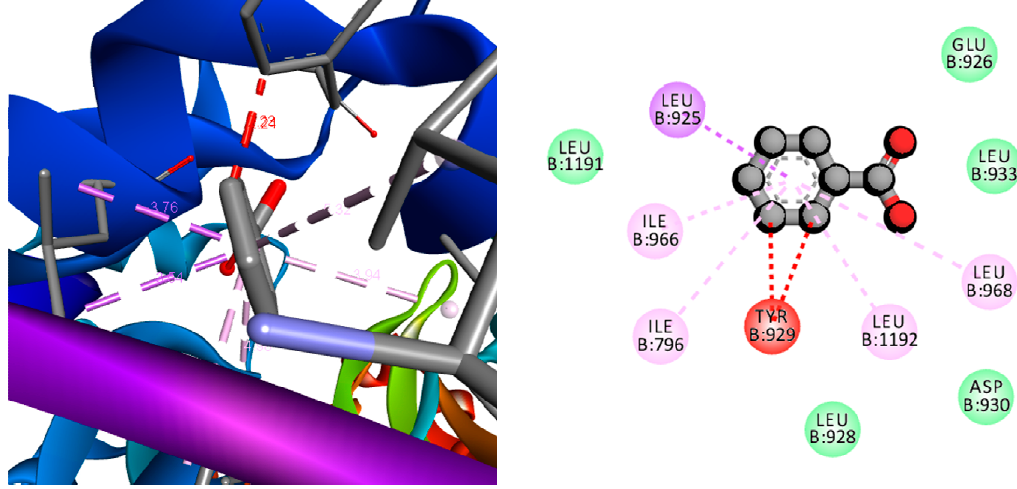
Figure 10. 3D and 2D docking pose showing the interactions between benzoic acid and methycilin resistant strain of Staphylococcus aureus (MRSA) related protein.